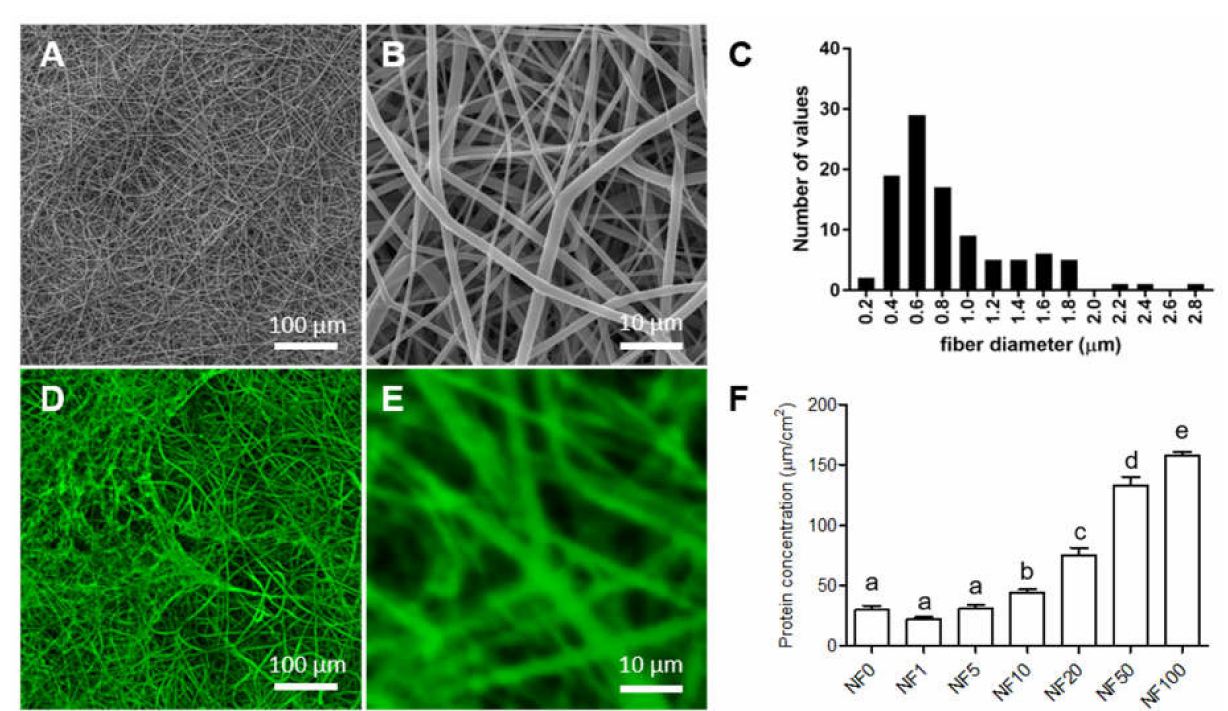
Figure 3. SEM images of the upper surface of a poly(L-lactide- co - ε -caprolactone)/poly( ε -caprolactone) (PLCL/PCL) nanofi- brous membranes ( A , B ). Histogram of the PLCL/PCL fibre diameter distribution on the upper nanofibrous membranes’ (NF) surface ( C ). Confocal laser scanning microscope (CLSM) images measured in phosphate-buffered solution of the fluorescence-stained proteins on the upper surface of the NF modified from a solution containing Fbg and 50% of platelet lysate (PL) (NF50) ( D , E ). The proteins were stained with fluorescamin (green). The protein concentrations in the NF0, NF1, NF5, NF10, NF20, NF50, and NF100 prepared from solutions containing Fbg and 0%, 1%, 5%, 10%, 20%, 50% and 100% of PL ( F ). The superscript letters above the columns denote significant differences between the values that do not share the same superscript ( p <